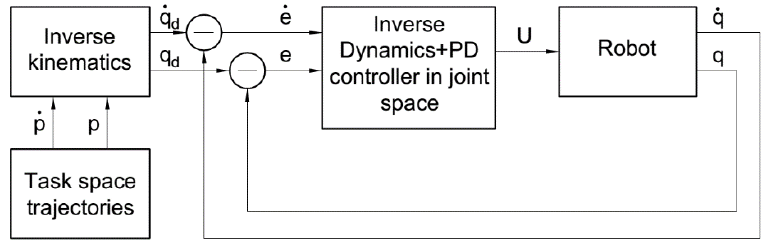
Figure 3. Scheme of the inverse dynamics method combined with the law of derivative proportional control (Inverse Dynamics + PD) controller in joint space